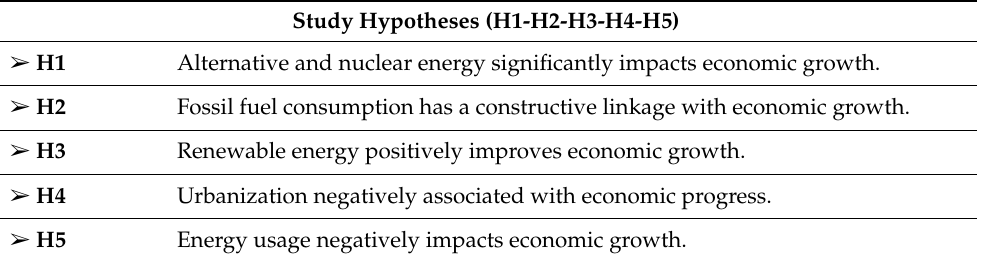
Table 3. Description of the study variables.